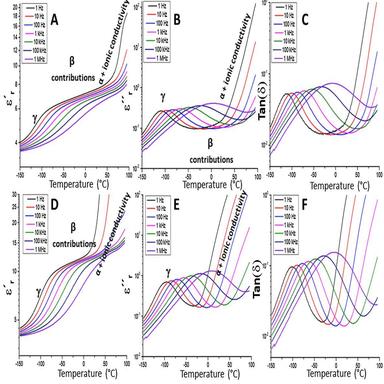
Evolution of ε′, ε″ and tan δ with temperature from −150 to 100 °C at different frequencies for PCNMeiT (A, B and C) and PDCNiT (D, E and F).